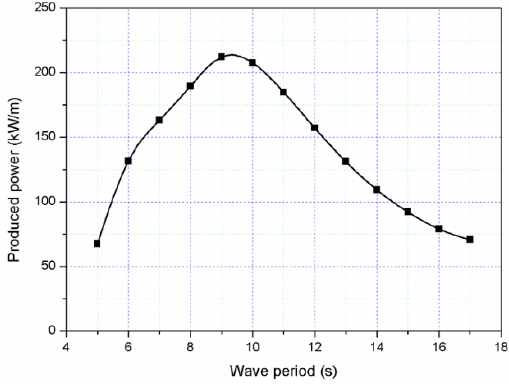
J. Mar. Sci. Eng. 2020 , 8 , x FOR PEER REVIEW Figure 5. Performance of the WEC with different wave periods. Figure 5. Performance of the WEC with di ff erent wave periods.